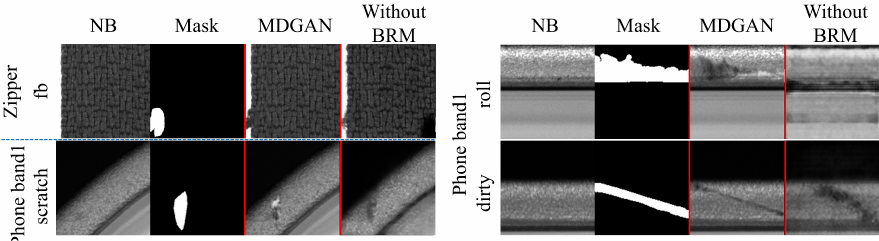
Figure 7. Comparison of with and without BRM. Background and Mask are input normal backgrounds and binary masks, MDGAN is the synthetic result of MDGAN. Without BRM is the synthetic result after canceling BRM.